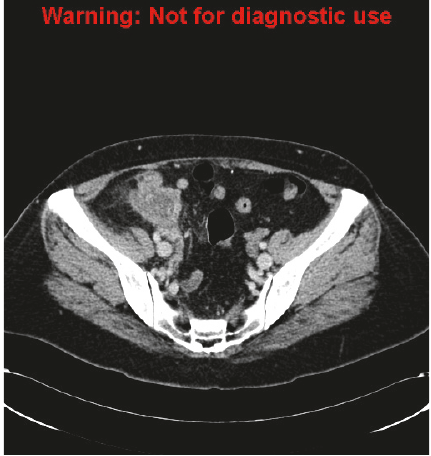
Figure 1: Coronal reconstruction demonstrating a drainage tube within the appendiceal collection.